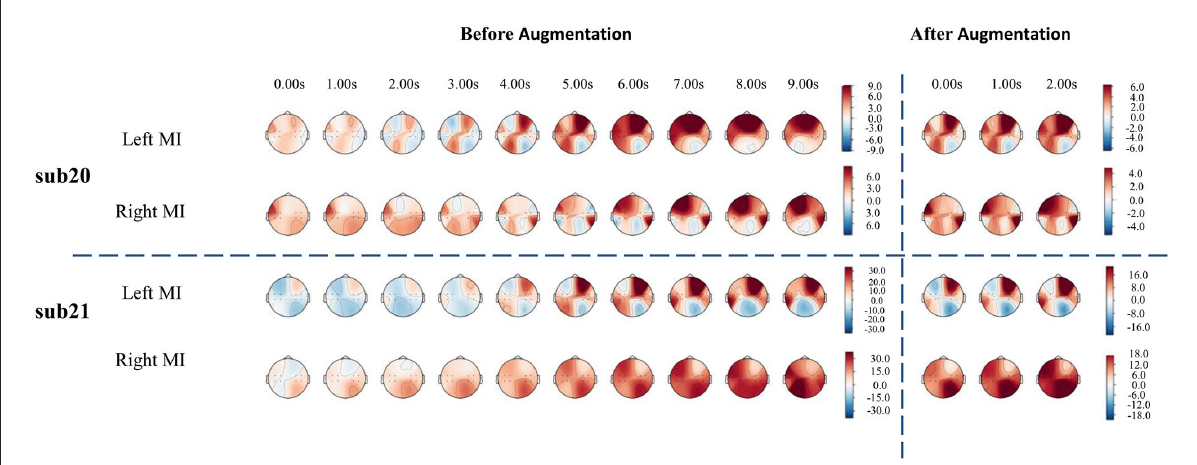
FIGURE6 The model training loss (sub09 as an example) varies with the number of epochs under different network architectures.